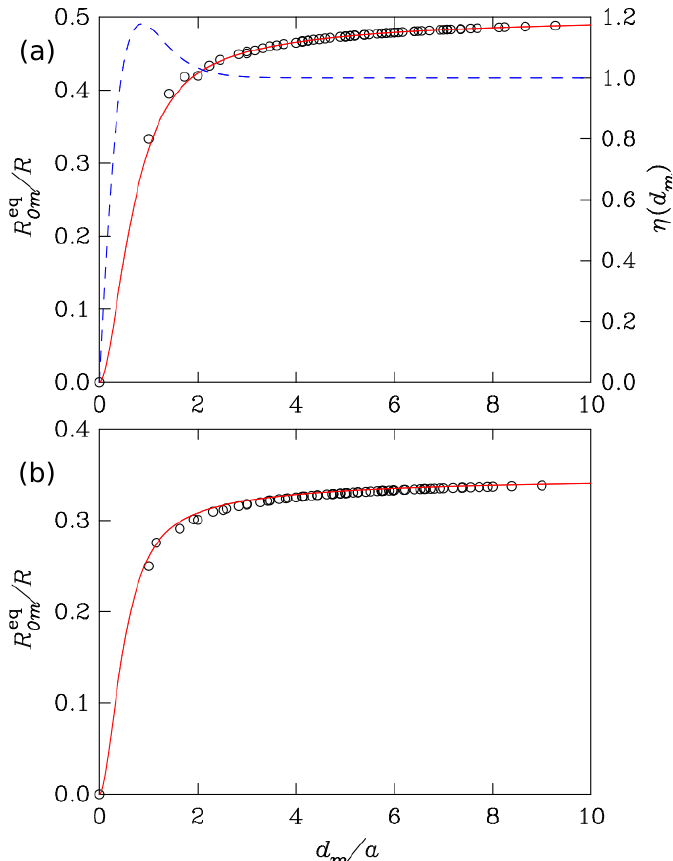
Figure 3. Plot of the equivalent resistance R eq between Sites 0 and m in a perfect resistor lattice 0 m versus separation distance d m . (a) and (b) panels correspond to the simple cubic (sc) lattice and the body-centered cubic (bcc) lattice, respectively. The open symbols are exact results from the literature. The red full-line curve is from Equation (10). The right-hand scale along the vertical axis of the (a) panel is for the blue dashed-line curve representing the simple expression (Equation (12)) of the correction function η ( d m )